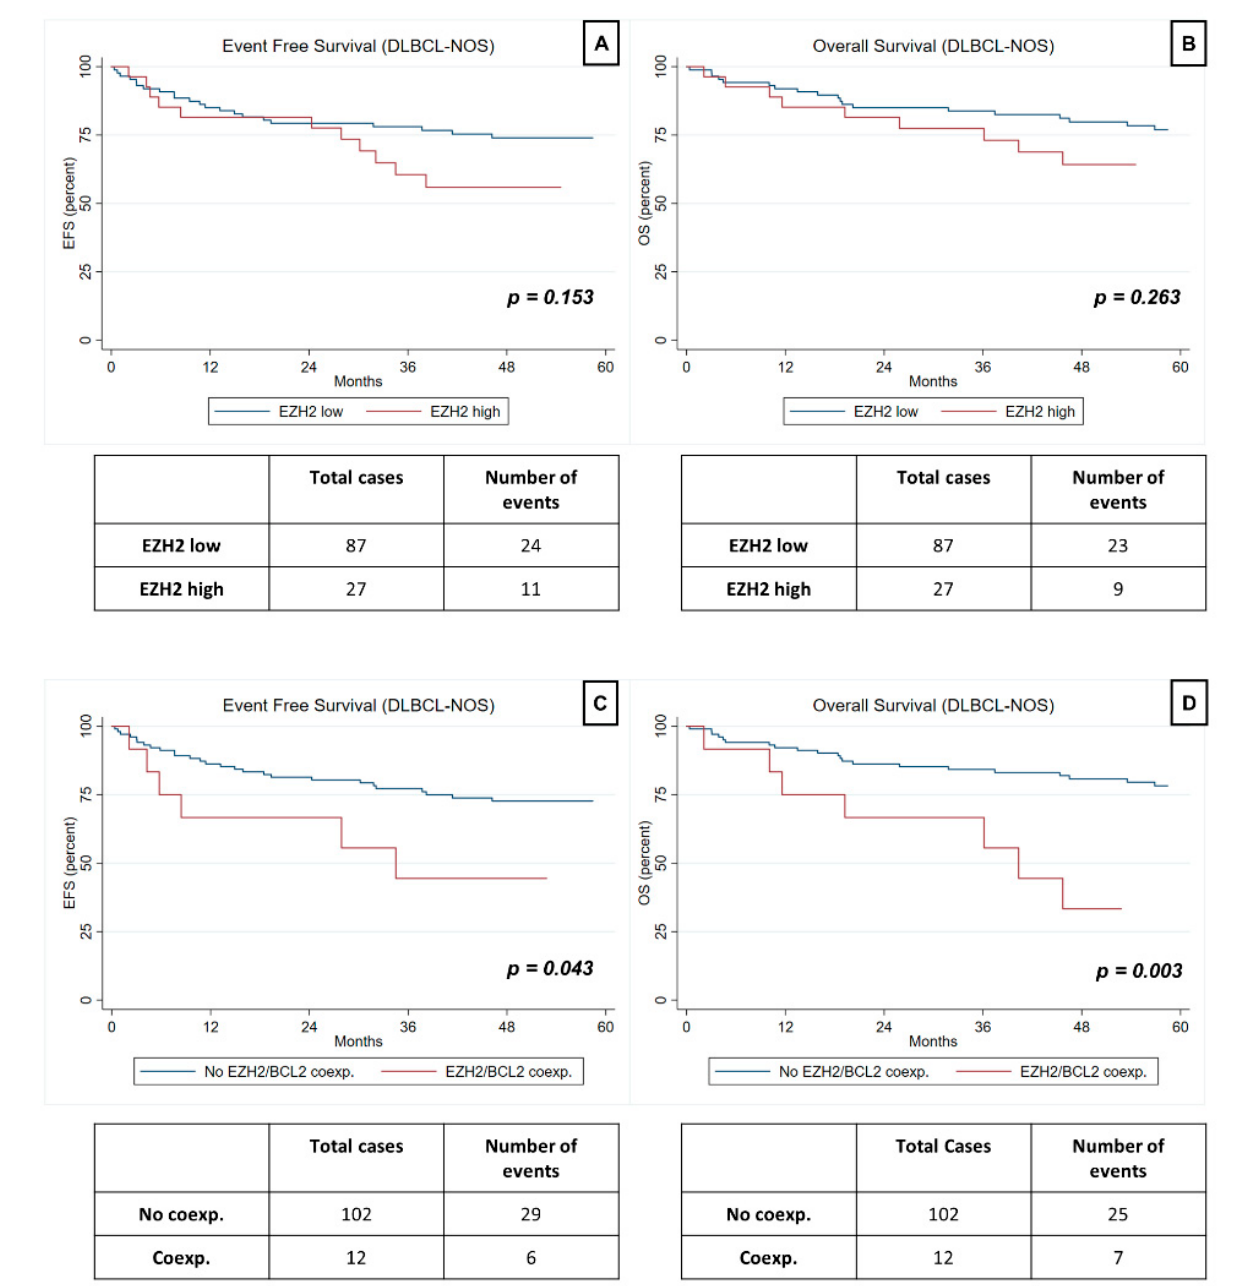
Figure 2. Univariate analysis of Event Free Survival (EFS) and Overall Survival (OS) in DLBCL-NOS. The displayed Kaplan Meier curves show comparison of EFS and OS with regard to: ( A ) and ( B )-EZH2 expression levels; ( C ) and ( D )-EZH2/BCL2 co-expression (coexp).